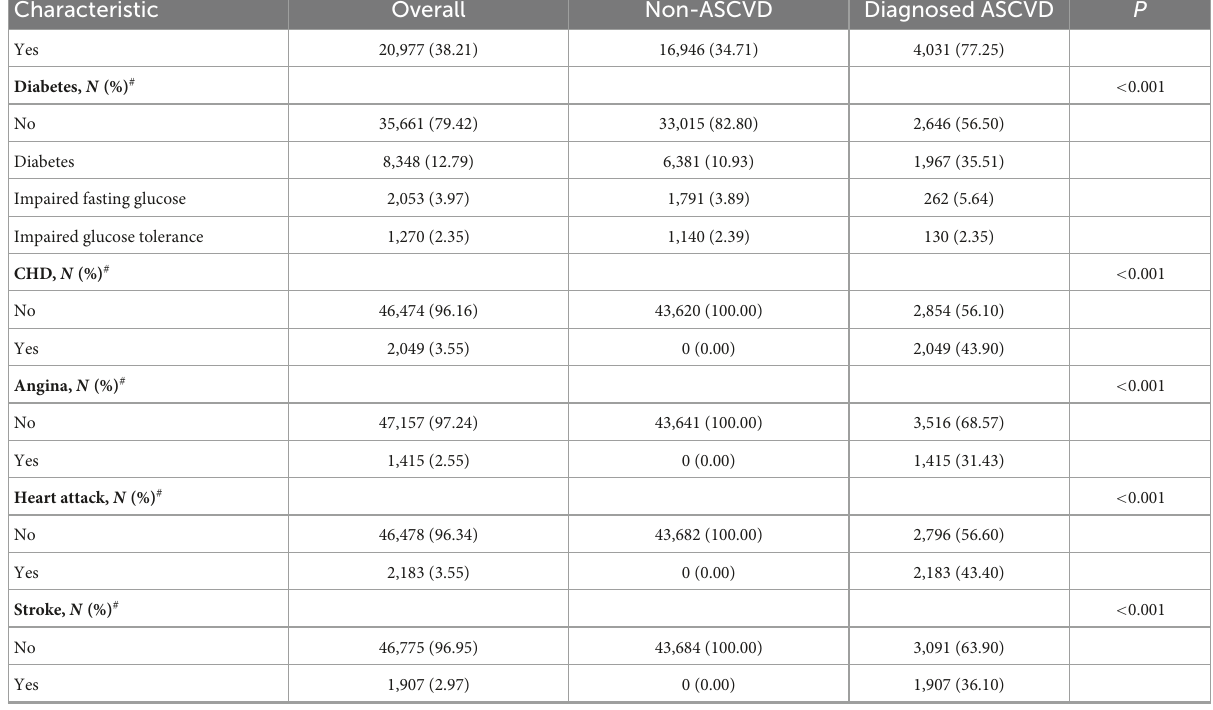
TABLE 2 Association between dietary inflammatory index (DII) and atherosclerotic cardiovascular disease (ASCVD). DII Event/Total OR (95% CI), weighted Decile Range Model 1 1 Model 2 2 Model 3